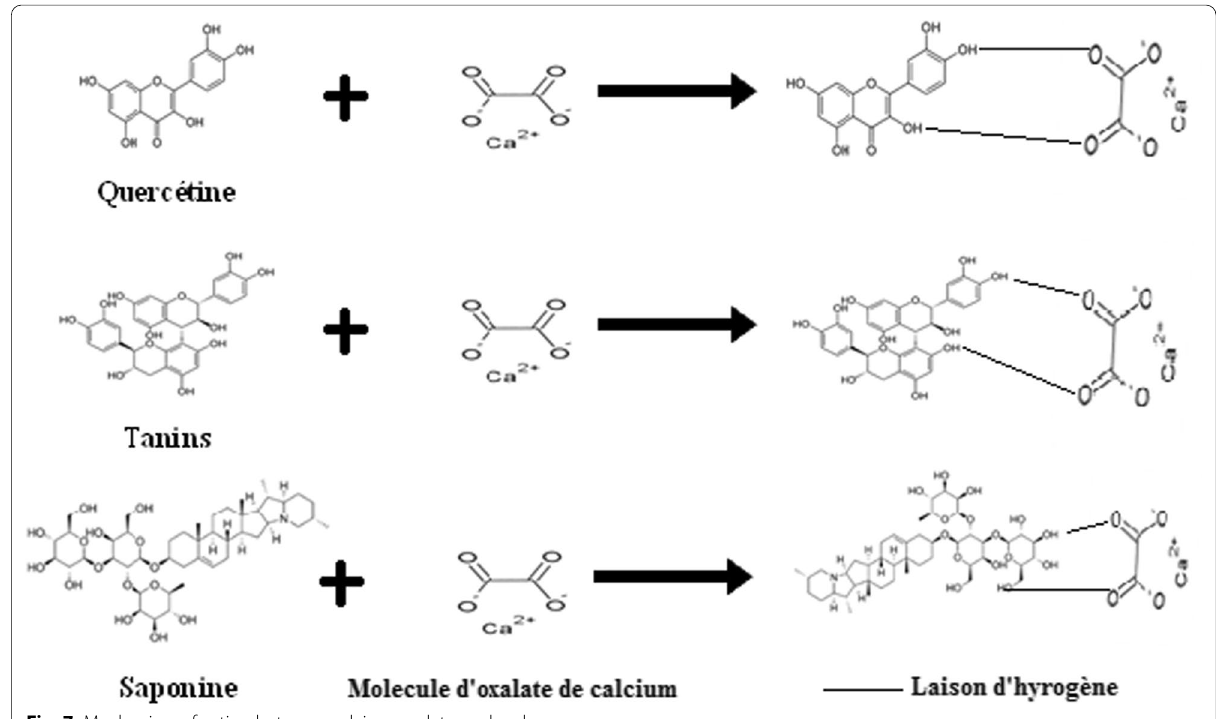
Fig. 7 Mechanism of action between calcium